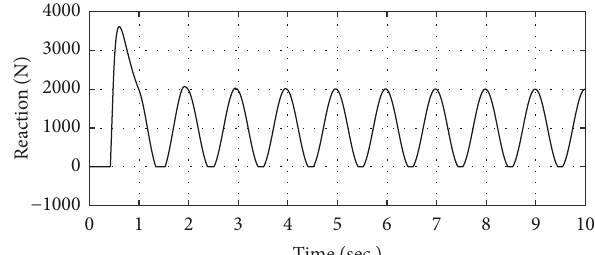
Figure 13: Time history of reaction 𝑅 in elastic-viscoplastic system shown in Figure 3.